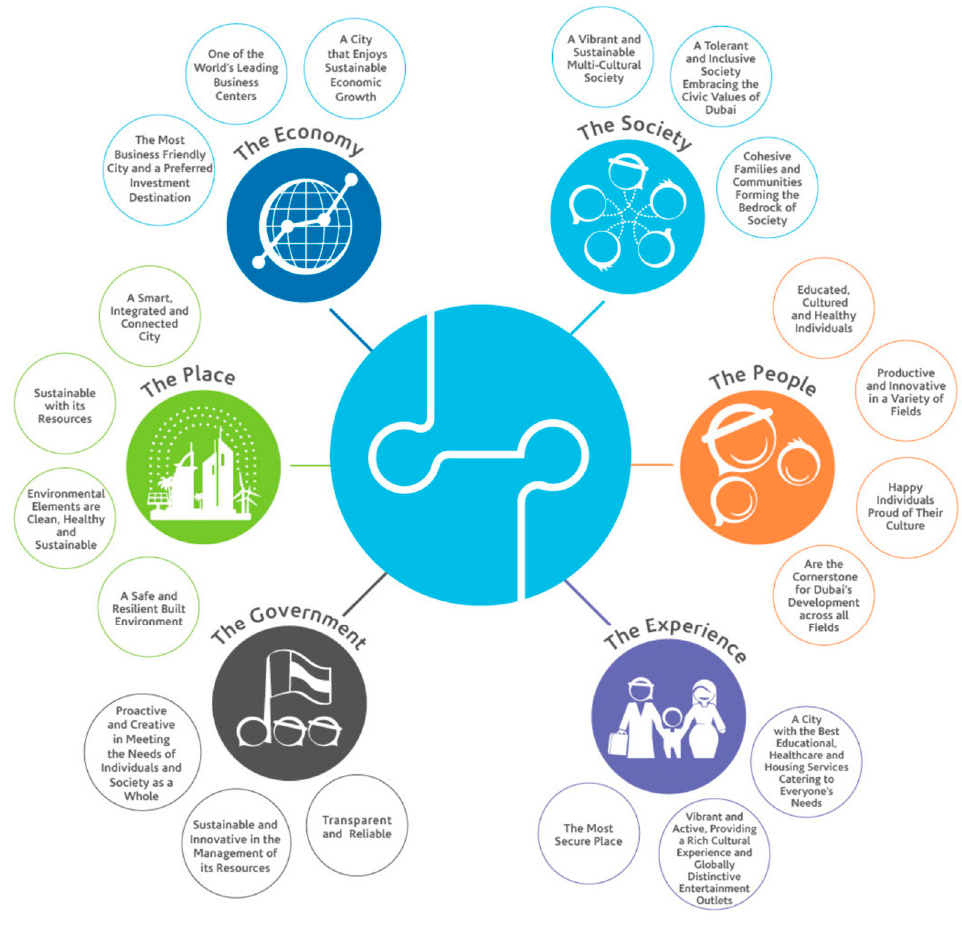
Figure 1. Schematic of the “Dubai Plan 2021”.